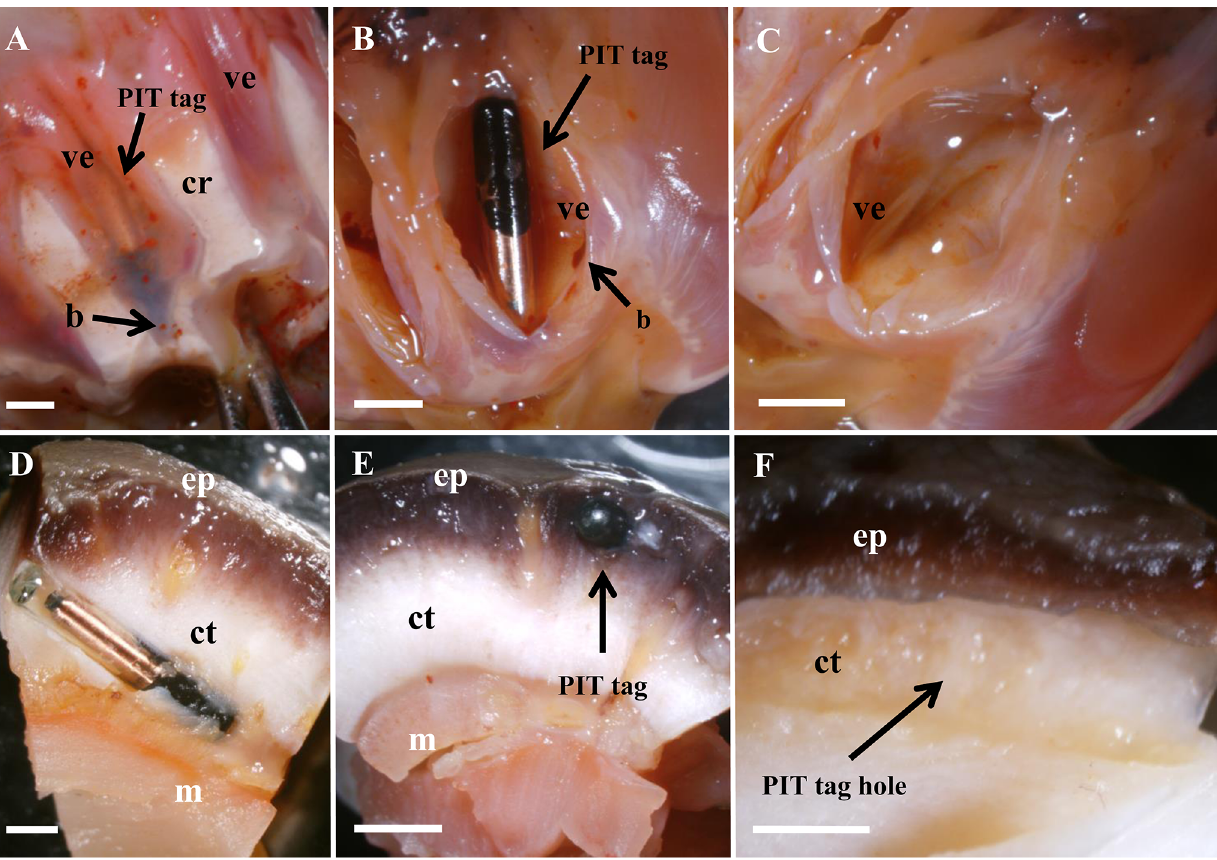
Fig 3. Localisation of retained PIT tags. (A-C) Tags retained in the aquapharyngeal bulb were found in the vesicles of the tentacles (ve). The calcareous ring (cr) and brown bodies (b) are identified. (D-F) Tags retained in the body wall were implanted in the connective tissue (ct) between the epidermis (ep) and the longitudinal muscle bands (m) below the ambulacral podia. Scale bars represent 2